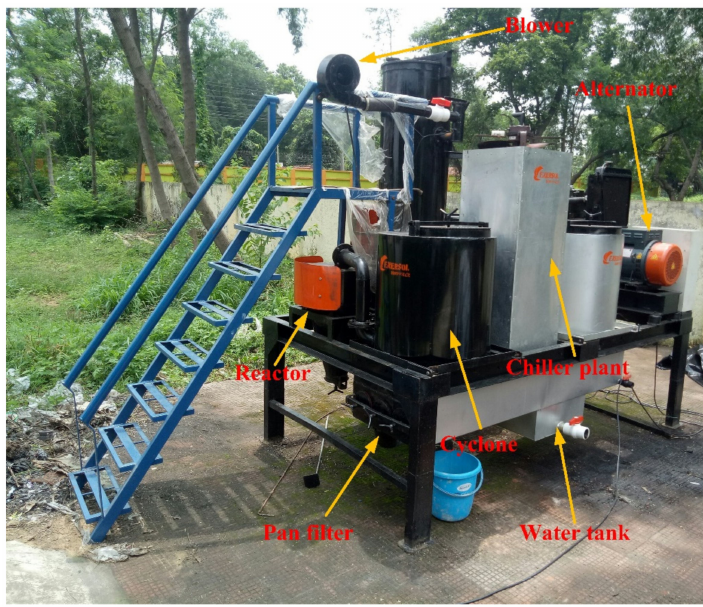
Figure 9. Rear view of the biomass generator